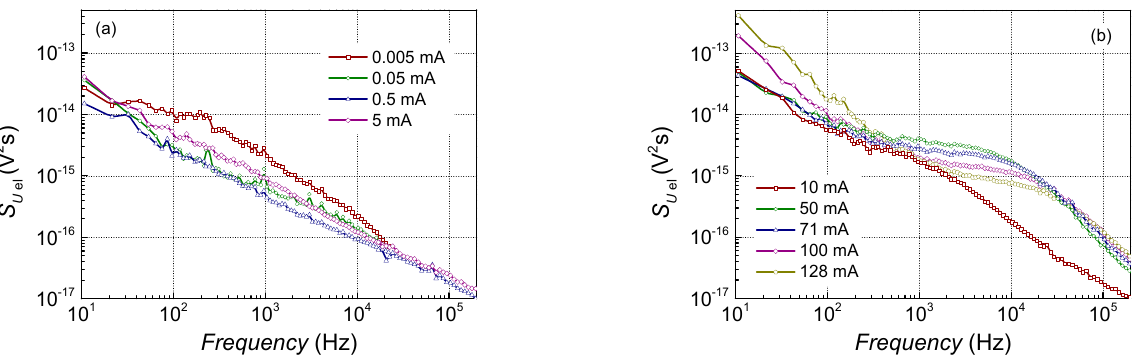
Figure 3. Typical current–voltage ( a ) and light vs. current ( b ) characteristics of the investigated lasers at room temperature (sample No. 6: AlGaAs-based LD with single parabolic QW).